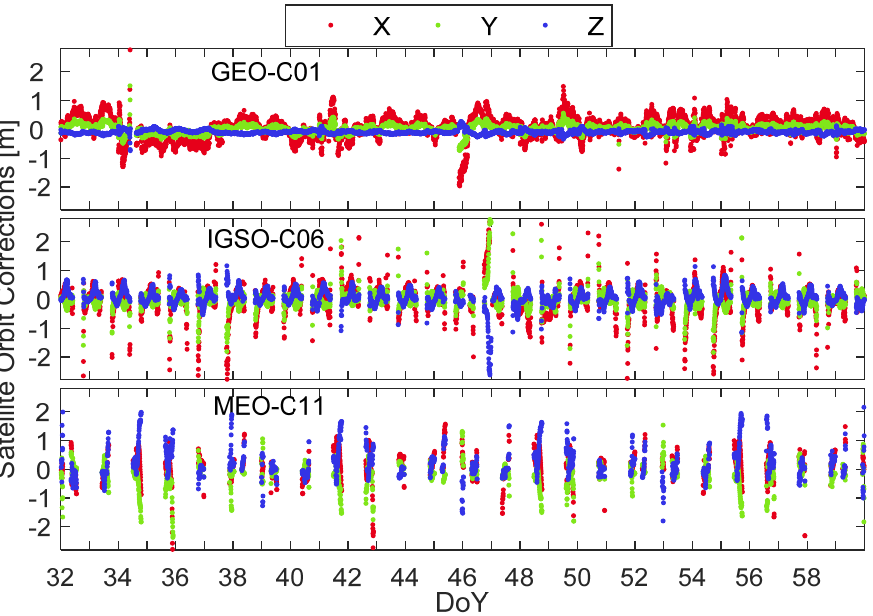
Figure 2. One-month BDS real-time orbit correction time series for C01, C06, and C11. Table 1. Statistics of BDS real-time orbit correction time series for C01, C06, and C11 (in meter).